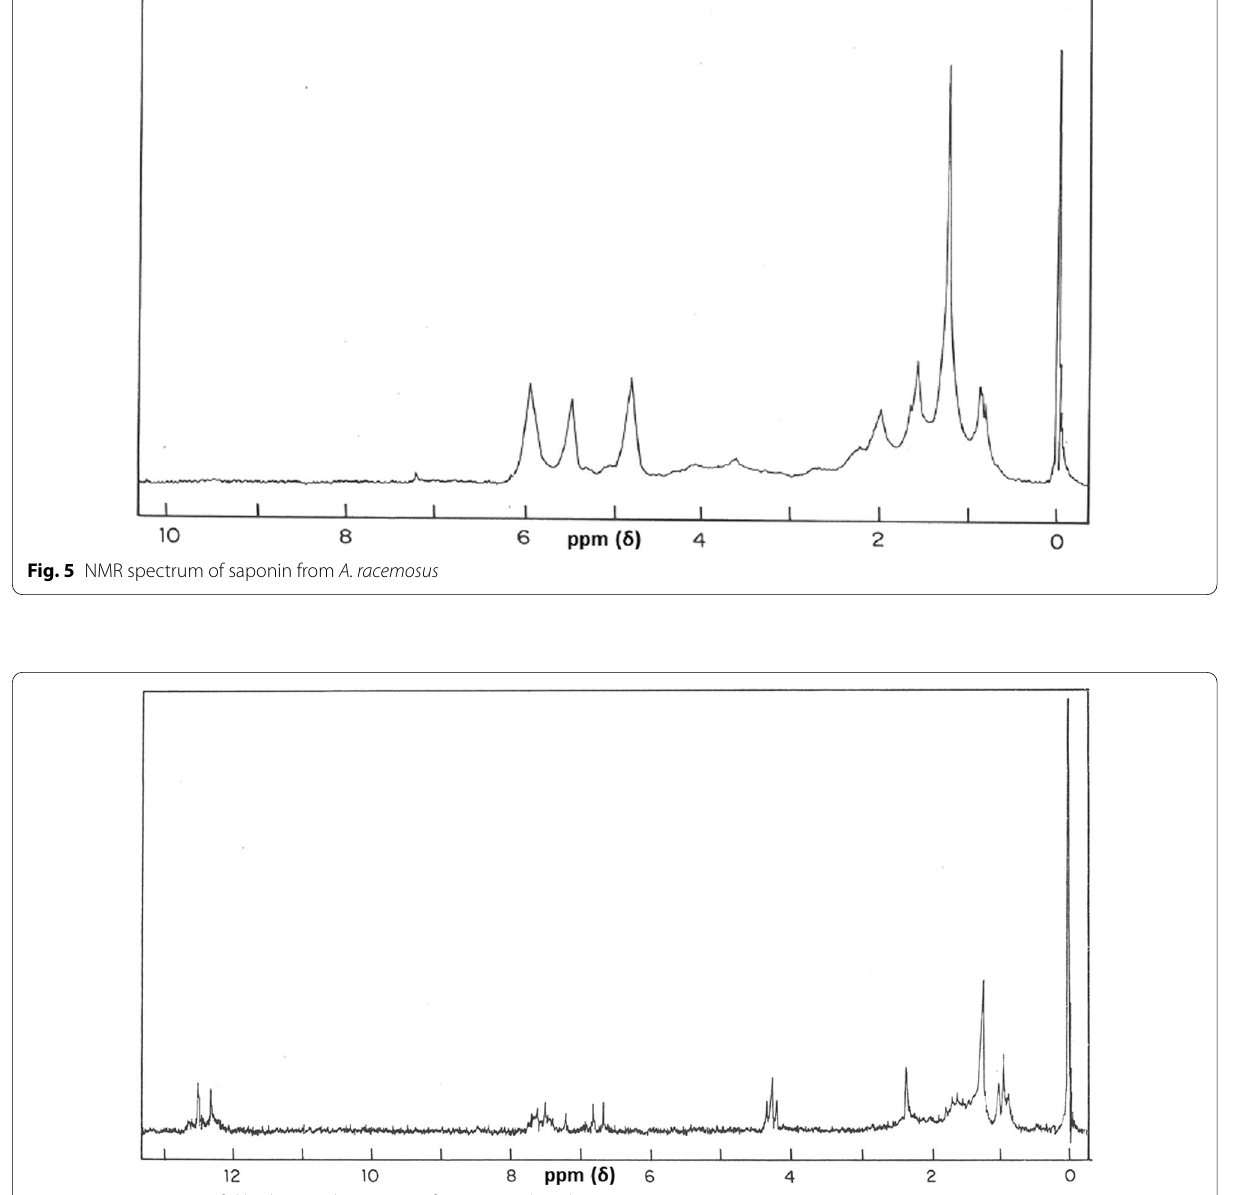
Fig. 6 NMR spectrum of dihydroxyanthraquinone from C.